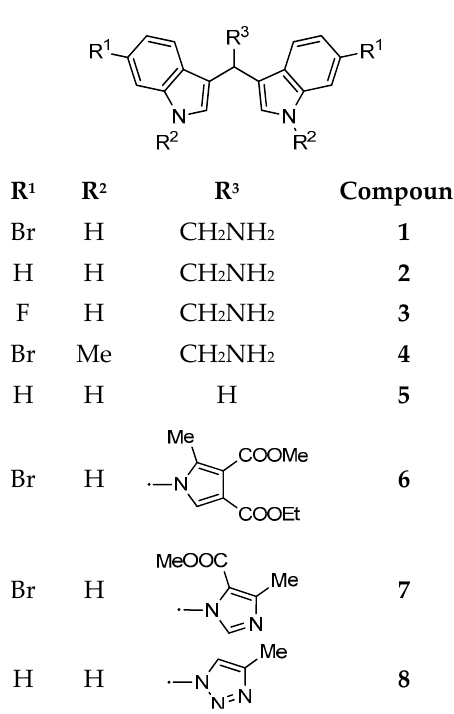
Figure 2. Marine bisindole alkaloid 1 and its synthetic derivatives 2 – 8 .